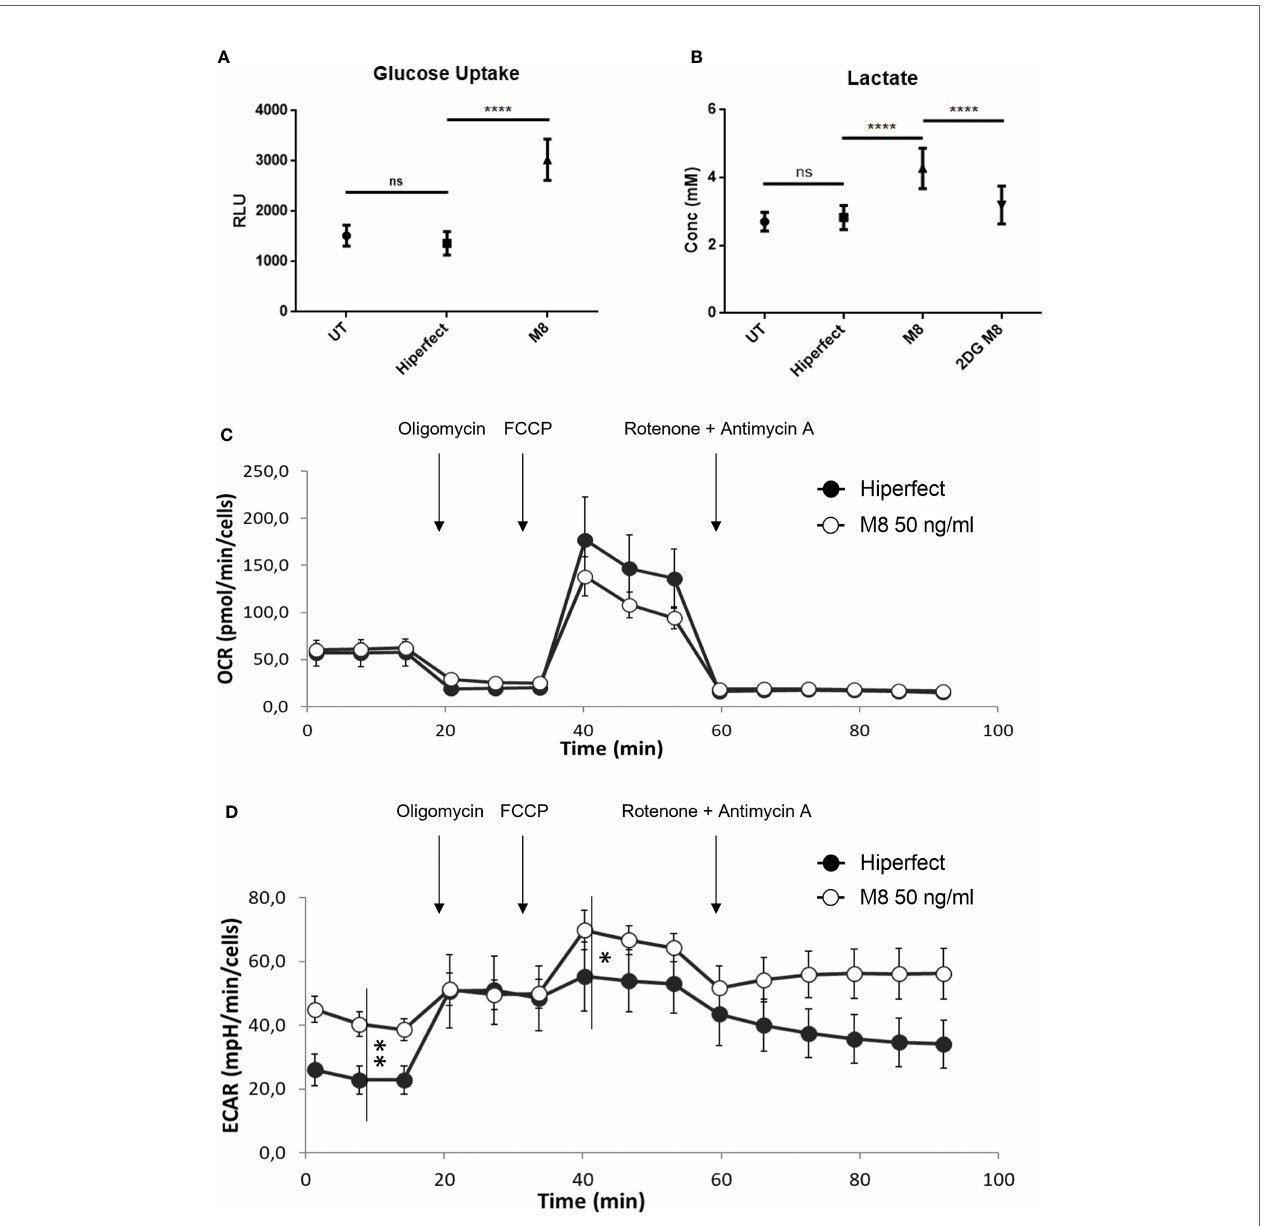
FIGURE 2 | M8 modulates glucose metabolism and bioenergetic pro fi le in monocyte-derived dendritic cells (MoDCs). (A) Eighteen hours after M8 treatment, MoDCs were incubated with 2-deoxyglucose (2-DG) for 20 min, washed, detached, and their 2-DG uptake capacity was measured by a colorimetric assay, as a measure of glucose uptake. Data are means ± SD of duplicates, obtained from three independent experiments. **** P < 0.0001. (B) MoDCs were stimulated with 50 ng/ml of M8 ± 6 mM 2-DG for 18h and lactate concentration in the medium was measured via a bioluminescent assay. Data are means ± SD of duplicates, obtained from six independent experiments. **** P < 0.001. (C) The mitochondrial respiration of MoDCs obtained by means of OCR by seahorse experiments and (D) the corresponding glycolysis obtained by means of ECAR after M8 treatment (open circles) compared to transfection control (black circles). Arrows indicate the addiction of drugs used to speci fi cally target the mitochondrial function (i.e., oligomycin, FCCP, rotenone + antimycin, in order of addiction. * P < 0.01; ** P < 0.0001. In the fi gure a representative experiment; values reported in the plot are the means of least 10 replicates ±